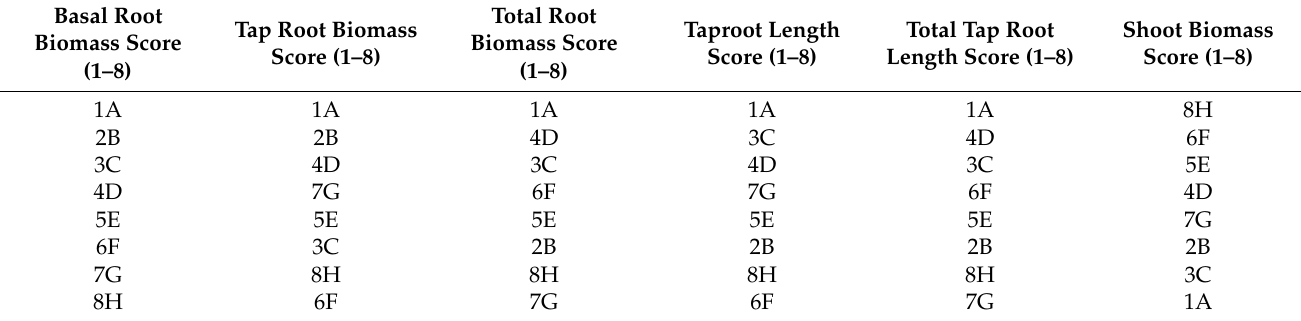
Table 4. Ranking of eight genotypes grown under low P and drought on root and shoot biomass. Basal Root Biomass